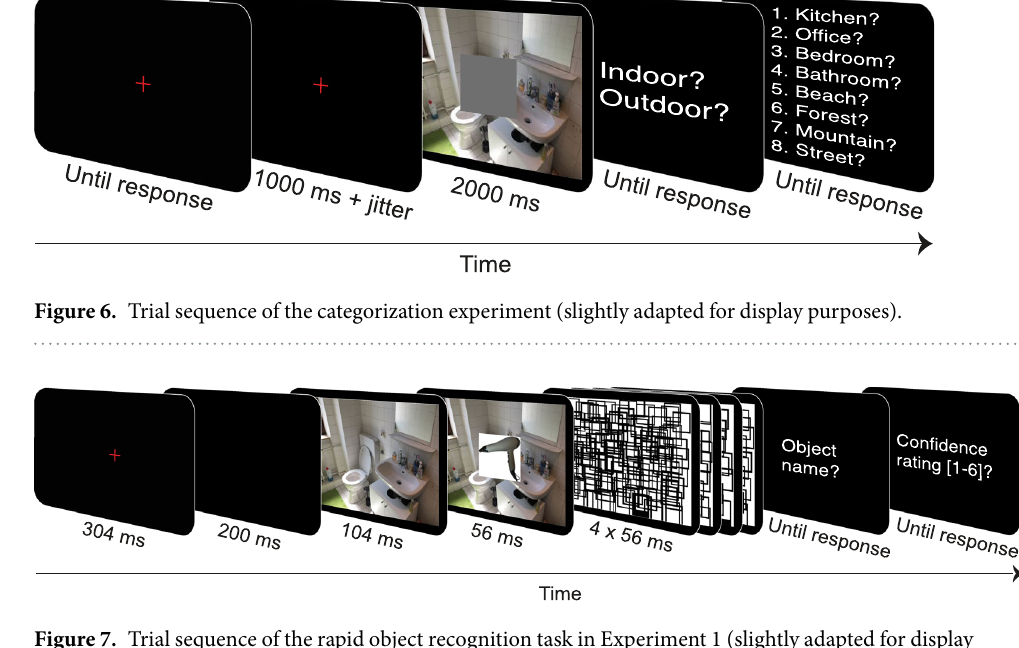
Figure 7. Trial sequence of the rapid object recognition task in Experiment 1 (slightly adapted for display